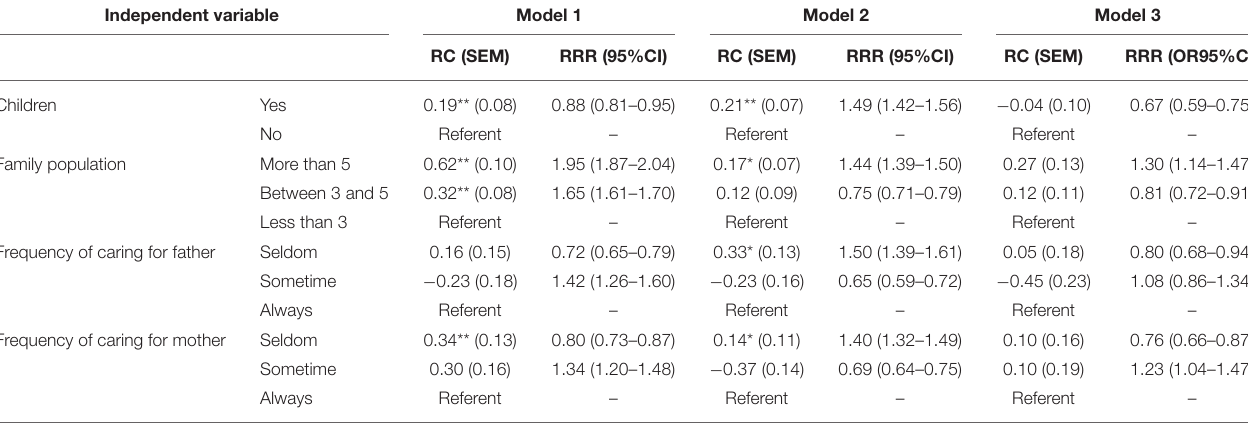
TABLE 3 | Multiple Logistic Regression models of contributing factors of female participation in physical activity (family